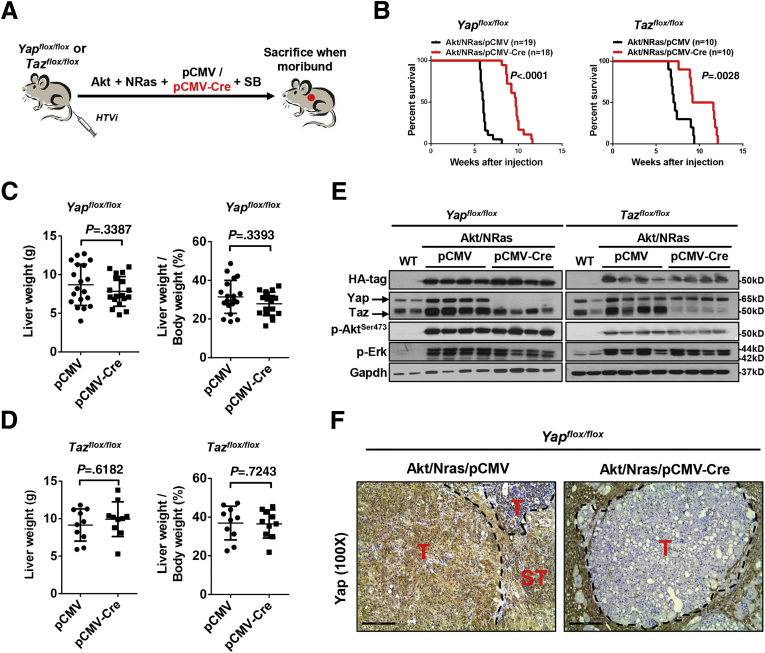
Yap and Taz are functionally redundant during Akt/NRas-driven mouse hepatocarcinogenesis. (A) Study design. Yapflox/flox or Tazflox/flox conditional KO mice were injected hydrodynamically with Akt/NRas/pCMV (control) or Akt/NRas/pCMV-Cre plasmids. (B) Survival curves of Yapflox/flox and Tazflox/flox conditional KO mice injected with Akt and NRas. Mice number in each arm is labeled in the figure. (C and D) Comparisons of liver weight and liver-weight-to-body-weight ratios in (C) Yapflox/flox and (D) Tazflox/flox murine Akt/NRas liver tumors. (E) Western blot analysis showing the expression levels of HA-tag, Yap (upper band), Taz (lower band), and activation of Akt and Ras pathways in wild-type (WT) normal livers, Akt/NRas/pCMV tumors, and Akt/NRas/pCMV-Cre tumors. (F) Immunohistochemical staining of Yap in Yapflox/flox murine Akt/NRas liver tumors. T, tumor; ST, surrounding tissues. Scale bar: 200 μm.